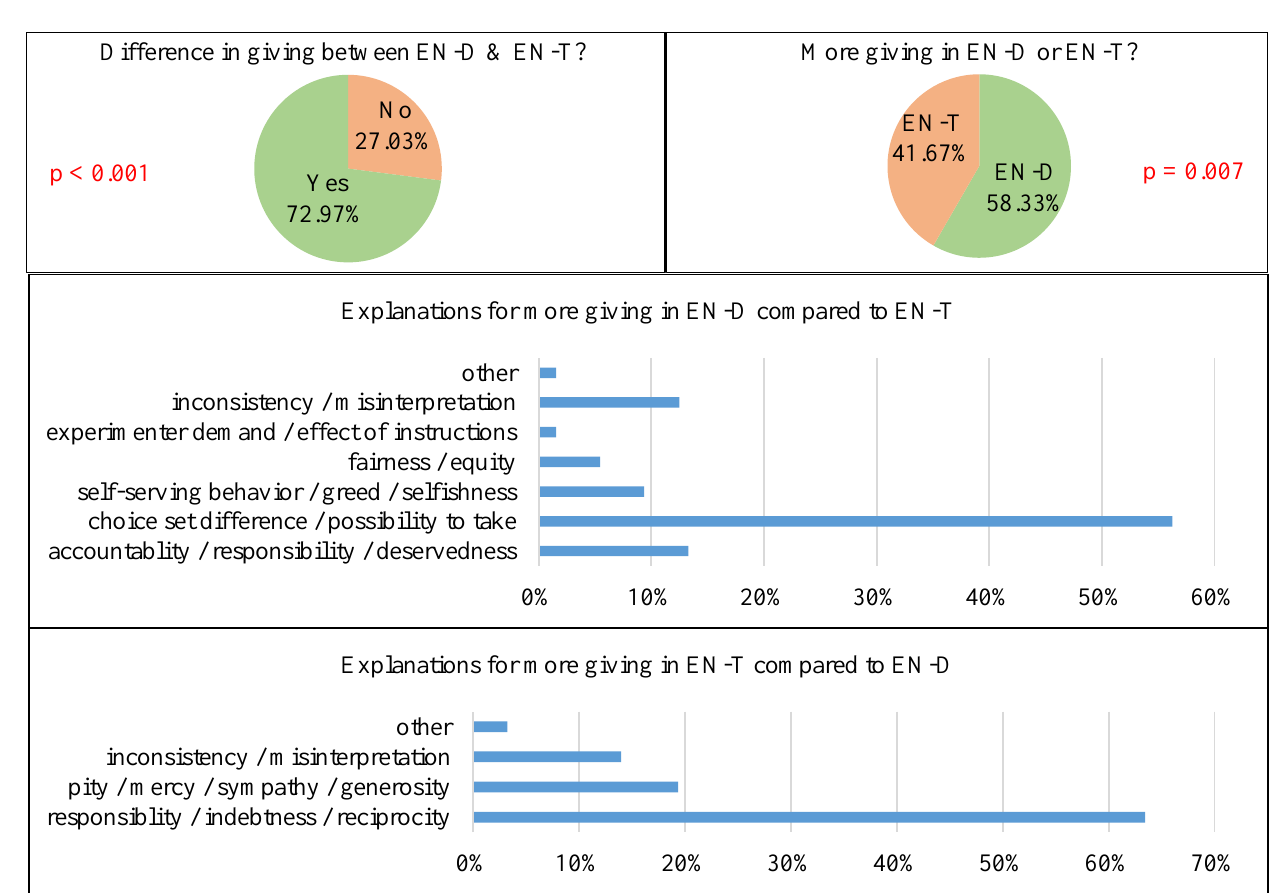
Figure 3. Survey results for Hypothesis 1 (exogenous games).